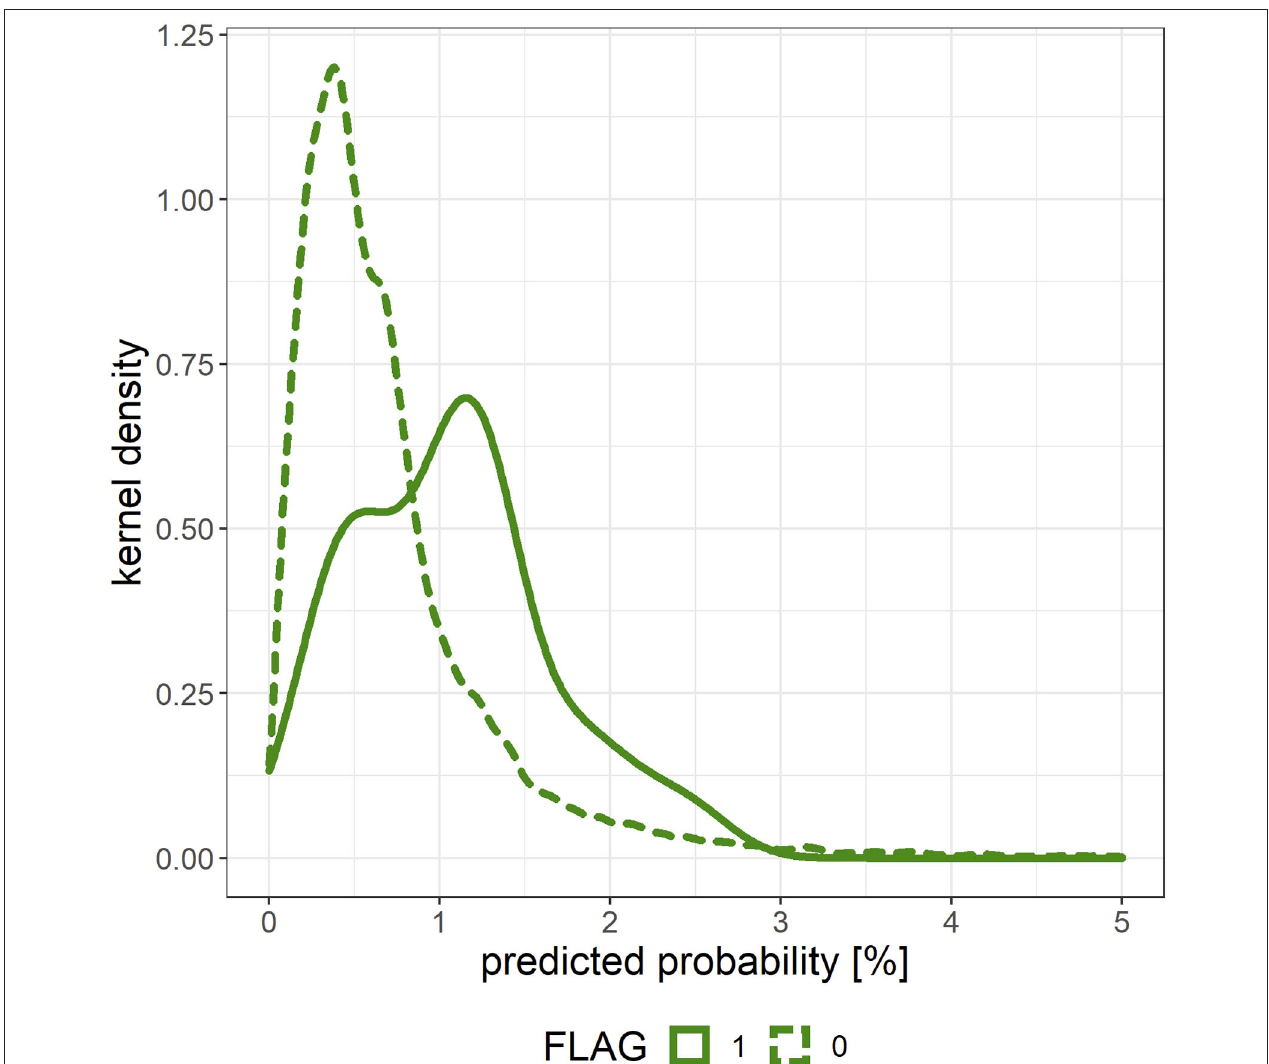
FIGURE 5 | Density estimation curve of the onset probability output by the predictive model for the merged validation data created by 10-fold cross validation. The solid line (FLAG = 1) corresponds to individuals with mental illness onset, and the dashed line (FLAG = 0) corresponds to those without mental illness